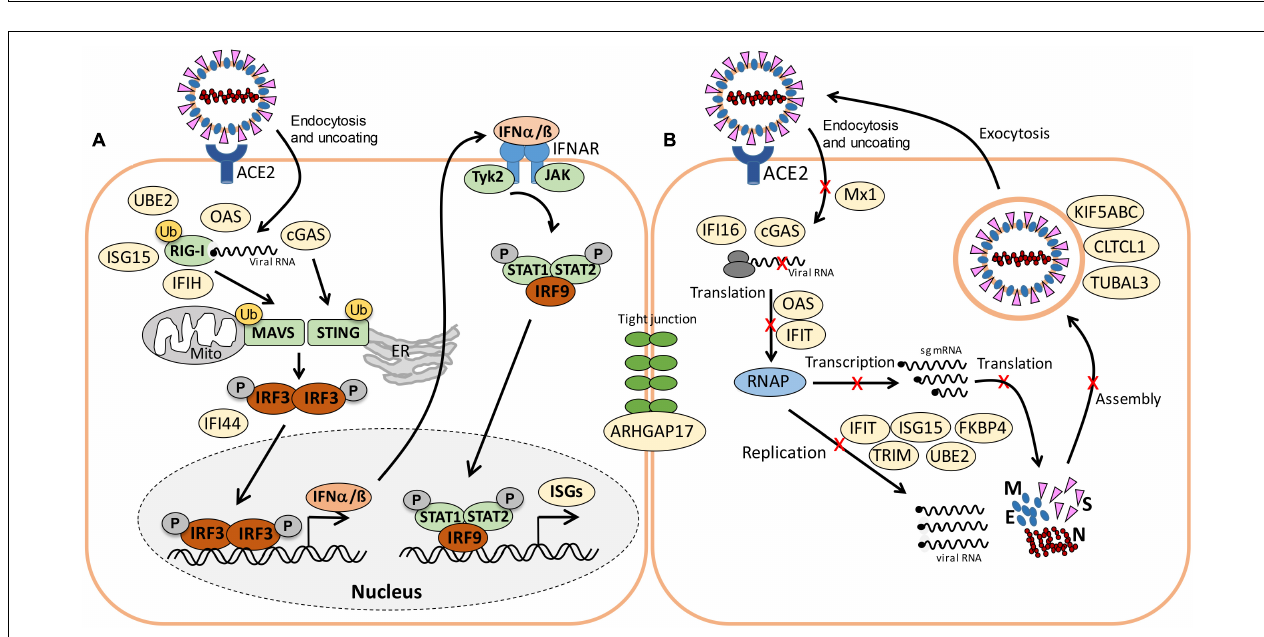
FIGURE 7 | Schematic of viral RNA recognition, activation of the IFN and ISG signaling pathways (A) and antiviral functions of the identified ISG effectors (B) in this host-virus proteome study. (A) SARS-CoV-2 enters host cells via endocytosis. RIG-I is a cytosolic receptor to recognize viral RNA. cGAS and OAS are ISG effectors that function as RNA sensors. RIG-I, IFIH, and cGAS activate the mitochondrial antiviral-signaling protein (MAVS) and stimulator of IFN genes (STING), leading to phosphorylation of IFN responsive factors (e.g., IRF3), followed by IRF3 dimerization, translocation into the nucleus and transcriptional activation of IFN expression. IRF3 is negatively regulated by IFI44. RIG-I, MAVS, and STING can be regulated by ubiquitination (UBE2) and ISGylation (ISG15). Type-I IFN a/ß bind to the IFNAR receptor, resulting in phosphorylation of signal transducers and activators of transcription (STAT1/2) by the JAK and TYK kinases. Phosphorylated STAT1/2 form dimers and bind to IRF9, which triggers transcription of IFN-stimulated genes (ISGs) in the nucleus. (B) Antiviral ISG effectors affect different stages of the viral life cycle. Mx1 inhibits virus endocytosis and uncoating of the ribonucleocapsid. IFI16, OAS, and IFIT function in viral RNA degradation and block translation. IFIT, ISG15, TRIM, and UBE2 inhibit transcription, replication, translation or virus assembly. FKBP4 promotes protein folding. Kinesins (KIFA/B/C), Clathrin (CLTCL1), and TUBAL3 are involved in transport of virus vesicles. ARHGAP17 facilitates the formation or repair of tight junctions. The figure is adapted from reference (Schneider et al.,